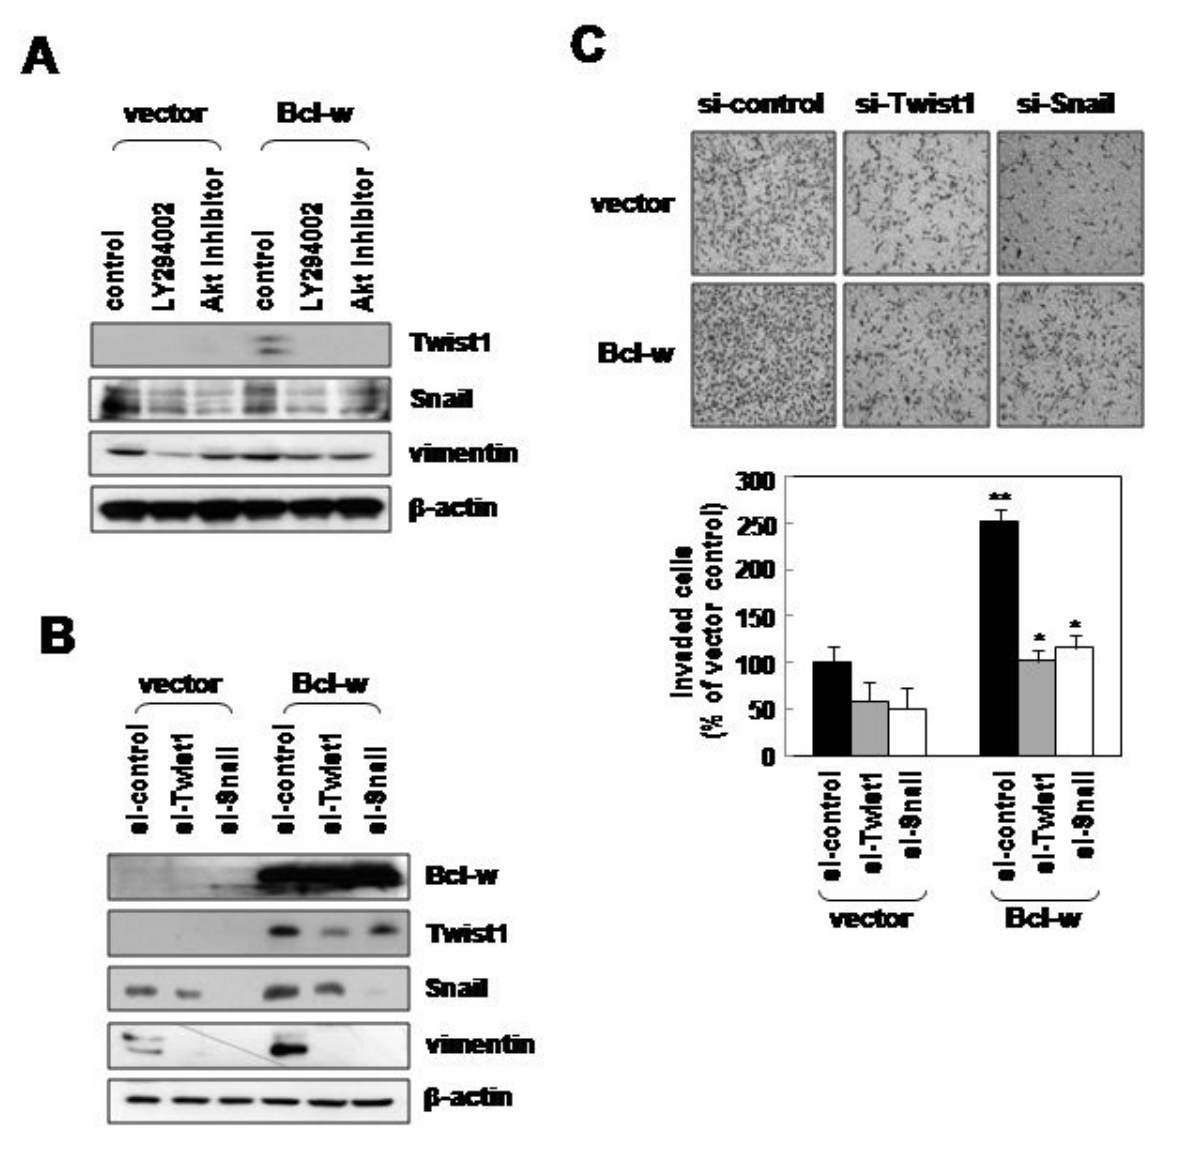
Figure 2. Twist1, Snail and vimentin regulate the invasiveness of glioblastoma cells. Down-regulation of Twist1 and Snail leads to inhibition of glioma invasion and vimentin expression. A , the indicated U251 cell transfectants were incubated in serum-free medium in the presence or absence of PI3K inhibitor (LY294002 (LY); 10 µmol/L) and Akt inhibitor (Akt-I; 10 µmol/L) for 1 hour. Expression levels of Twist1, snail and vimentin proteins were compared using Western blotting. B , control or Bcl-w-expressing U251 cells were transfected with 20nM of Twist1, Snail or vimentin siRNA for 24 hours and were subjected to Western blotting with mesenchymal-related proteins or anti-Bcl-w antibodies. C , cells in Figure 2B incubated in a Matrigel-coated transwell for 20 hours. *, p < 0.05, **, p < 0.005, n =